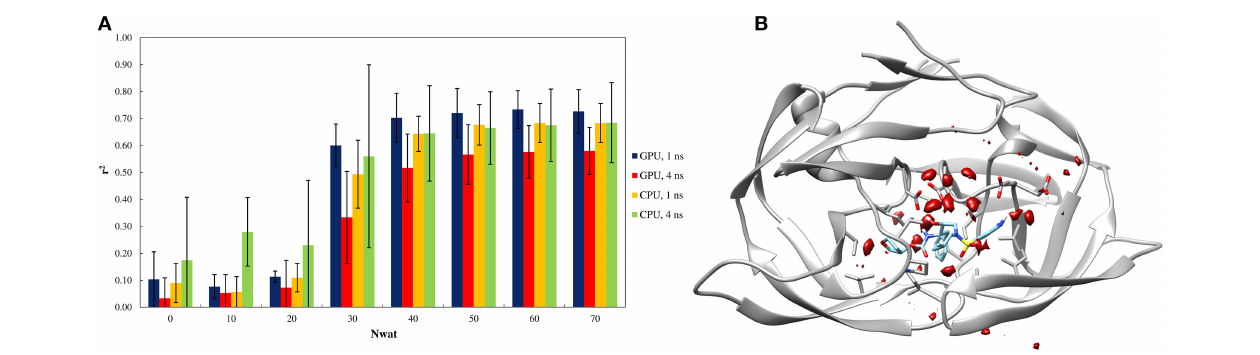
FIGURE 3 | (A) Trend of r 2 in dependency of Nwat for HIV1-protease. Nwat = 0 corresponds to a standard MM-GBSA calculation. (B) Water density plot obtained by grid analysis of HIV1-protease-3NUO complex (visualization with Chimera, step = 1, level = 15).